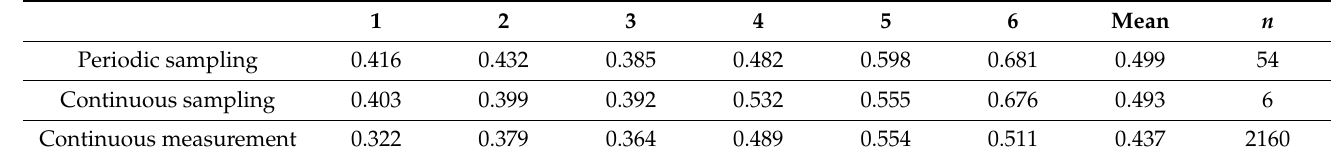
Table 5. Comparative CH 4 concentration by sampling method (unit: ppm).